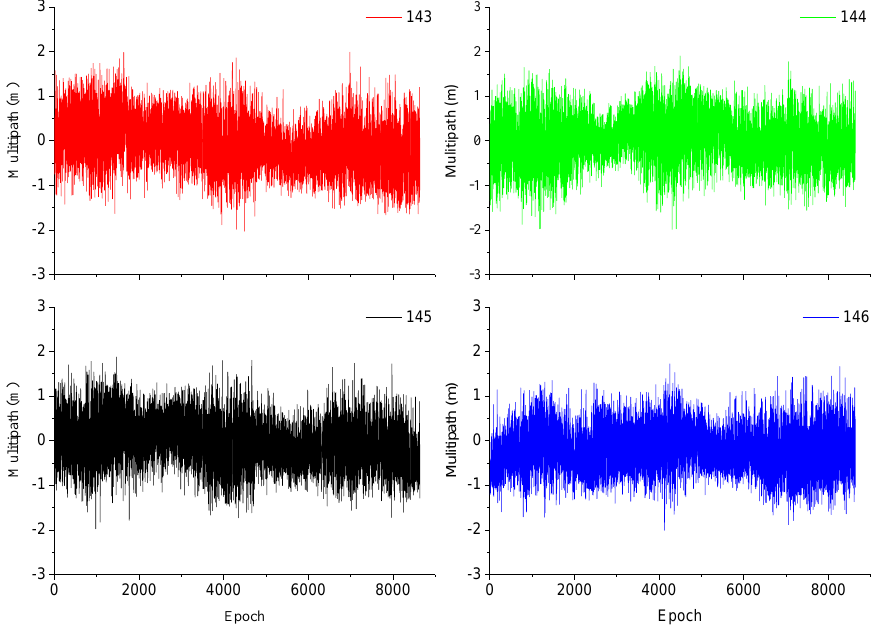
Figure 6. Four-day multipath series of IGSO observations with the Trimble receiver.